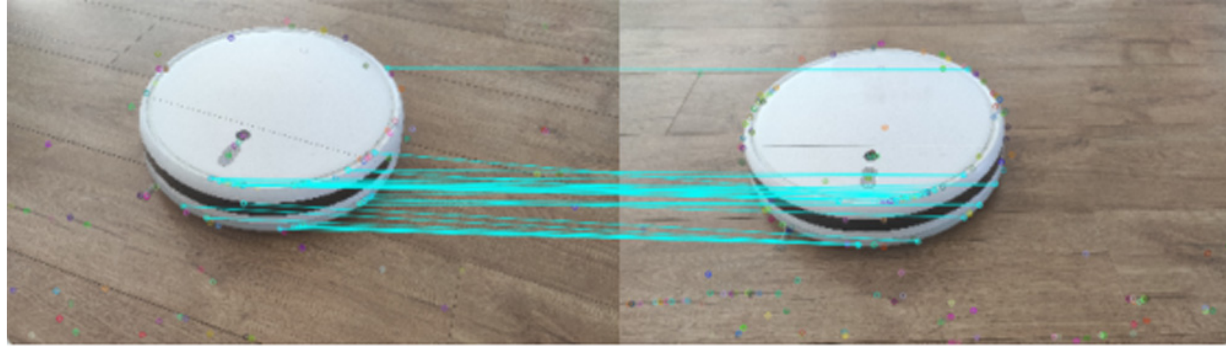
Figure 3. Feature points extraction and matching result of the proposed method.